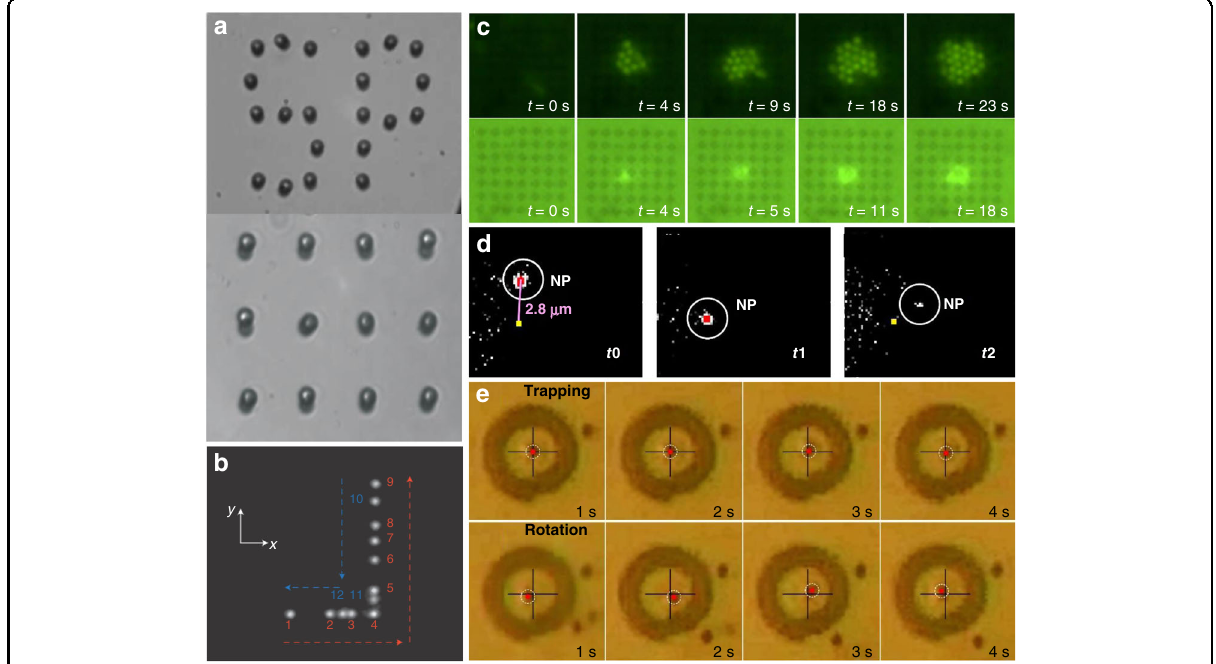
Fig. 7 Surface plasmonic trapping con fi guration through designed nanostructures. a Plasmonic traps through pro fi led metallic structures, in which a pattern of micrometre-sized gold discs is illuminated under the Kretschmann con fi guration through a glass prism. b Composite image reproducing the displacement of a trapped object by a bowtie plasmonic aperture at the extremity of a tapered metal-coated optical fi bre. c Multiple particle trapping of nanospheres in a two-dimensional nanoscale plasmonic optical lattice. d Trapping and release of a single 20-nm nanoparticle by double nanoholes (approximate position: yellow dot). e Selective trapping or rotation of a single microsphere. a Reproduced with permission